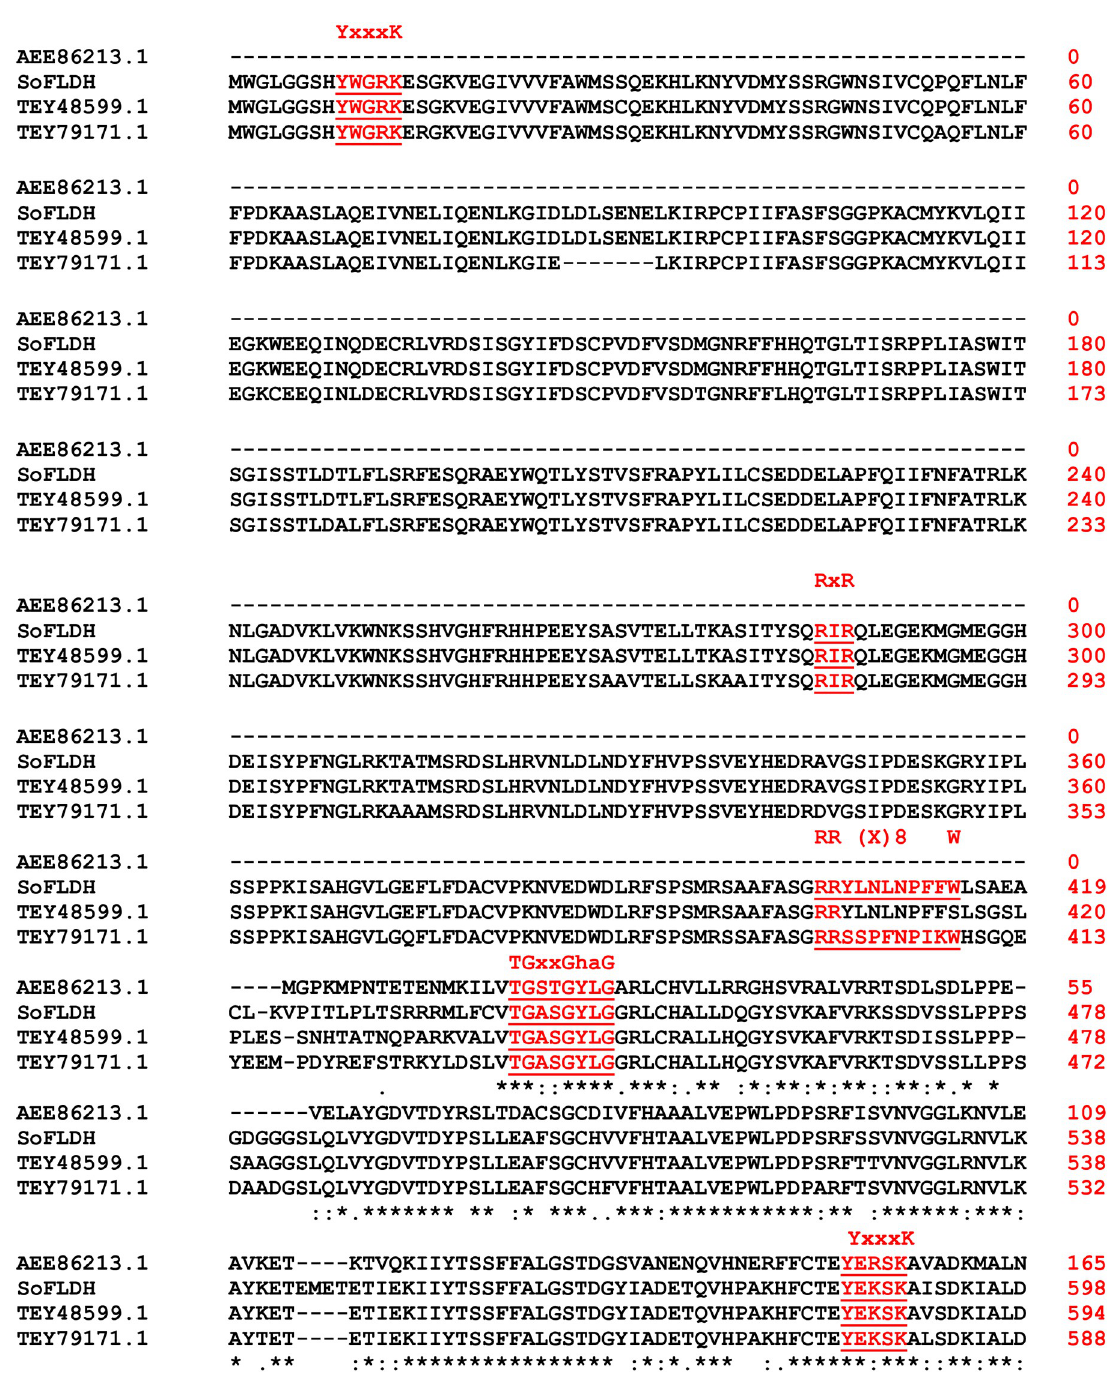
Fig 2. Multiple sequence alignment. The deduced amino acid sequence of SoFLDH was aligned with homologues identified from the BLASTX analysis. The conserved motifs YxxxK, RXR, RR(X8) W and TGxxGhaG aremarked. SoFLDH : NAD+-dependent farnesol dehydrogenase [ Salvia officinalis ]; farnesol dehydrogenase [ Salvia splendens : TEY48599.1]; hypothetical protein Saspl_009804 [ Salvia splendens : TEY79171.1]; NAD(P)-binding Rossmann-fold superfamily protein [ Arabidopsis thaliana , AEE86213.1].